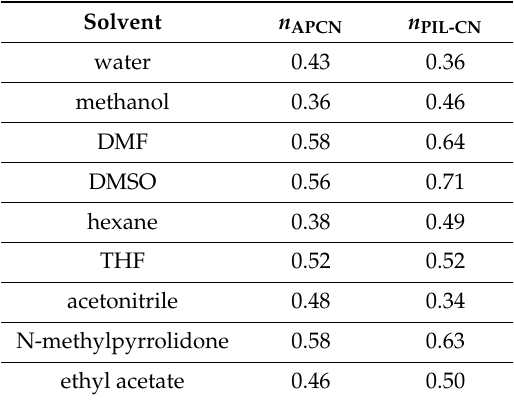
Table 3. The exponents of the swelling degree versus time curves obtained by the Korsmeyer–Peppas relationship for the PVIm- l -PTHF-57 ( n APCN ) and PVImMe- l -PTHF-57 ( n PIL-CN ) conetworks swollen in di ff erent solvents. Solvent n APCN n